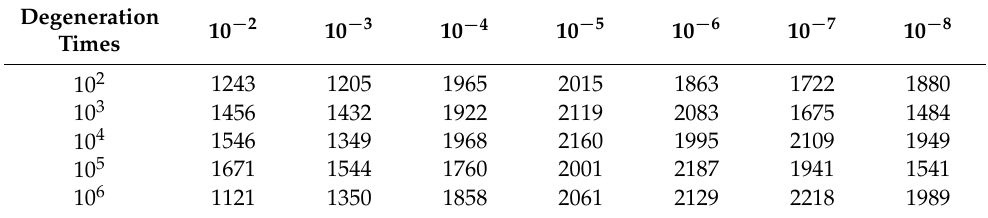
Table 7. Effect of degeneration times on low-probability password hits (Rule